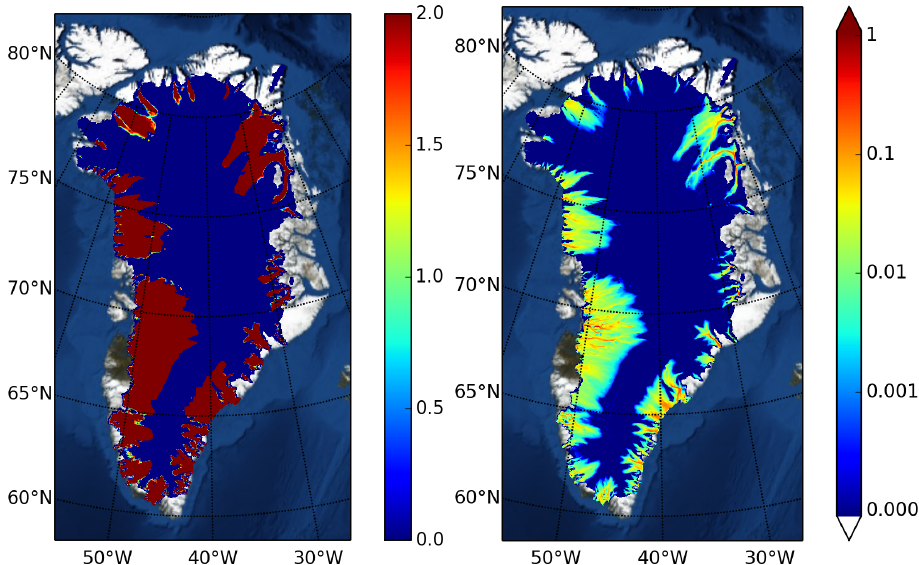
Figure 7. Outputs from the routing hydrology model are the modeled till-stored water layer thickness W til (left; m) and modeled trans- portable water layer thickness W (right; m).